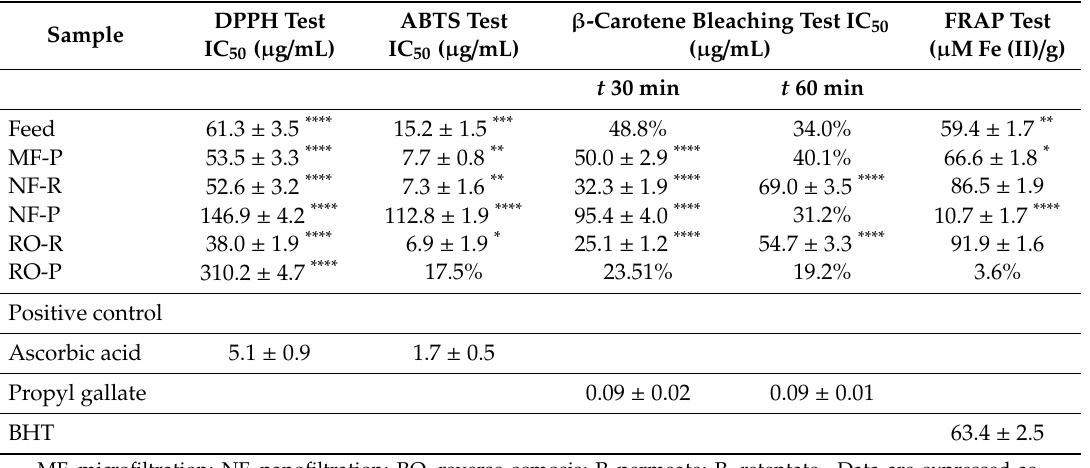
Table 3. In vitro antioxidant